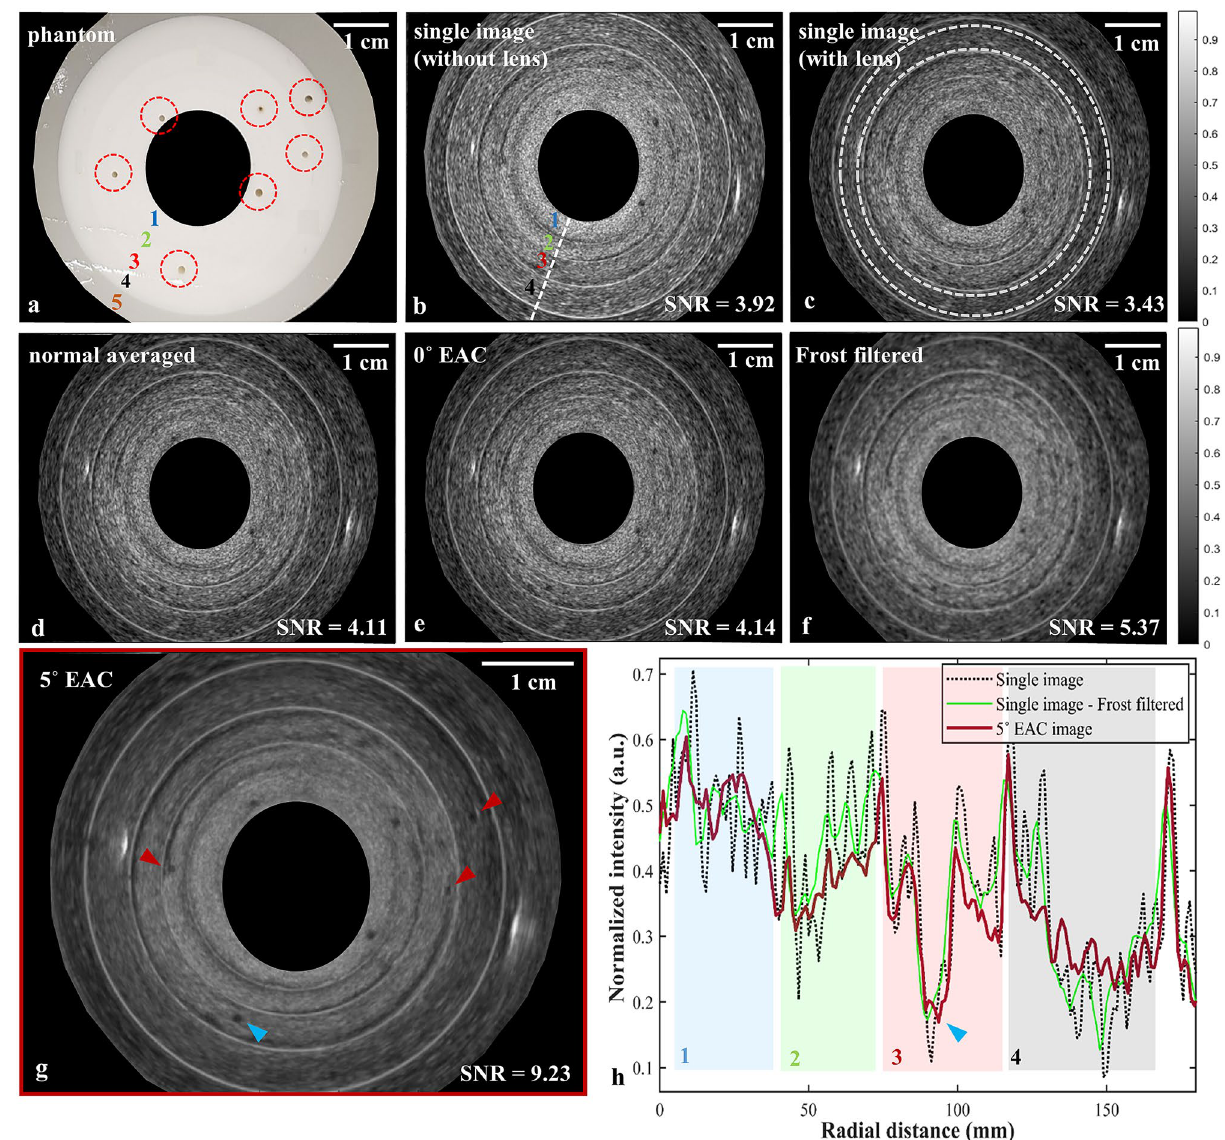
Figure 2. Speckle reduction by REACT in a radial geometry compared to single images, averaging, and Frost filtering. (a) Phantom A: a five-layered cylindrical phantom (labelled with numbers 1, 2, 3, 4, and 5 from inside out respectively) containing seven holes (specified with circular regions). (b–g) US images of Phantom A: (b) a single image recorded without an acoustic lens, (c) a single image recorded with a stationary acoustic lens, (d) an averaged image using 100 single images recorded with a stationary acoustic cylindrical lens (e) a compounded image using 100 single images recorded with a translating acoustic cylindrical lens providing 0° elevational deflection, (f) a single image recorded with an acoustic lens after Frost filtering, (g) a compounded image using 100 single images recorded with a translating acoustic cylindrical lens providing 5° elevational deflection. The red arrows indicate holes that are not visible in b-f. Region between two white circles in c show the ROI used to derive the SNR in (b)–(g) . (h) A-line intensity profiles for the single, Frost filtered, and 5° EAC images, which were recorded along the dashed line shown in b. The blue, green, red, and gray rectangles indicate phantom layers 1, 2, 3, and 4, respectively. Blue arrows in g and h point to the same hole, which lies on the dashed line in (b)